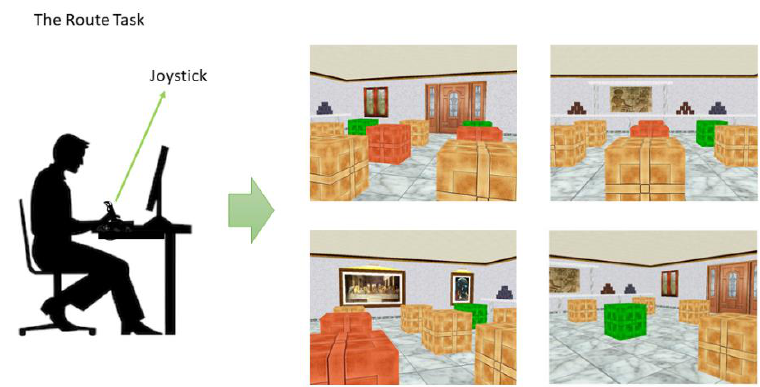
Figure 1. Four examples of the Route Task in the virtual room. Participant can move around the room with a joystick using a first person, egocentric perspective. Note that boxes are brown, and they changed their colour when opened. Green boxes represent right choices whereas red boxes indicate errors.